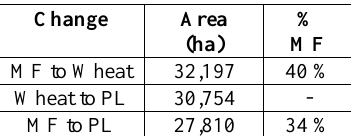
Table 5 . Historic transformations from the interested land covers in the study area. MF = Maulino Forest. PL = Plantation.